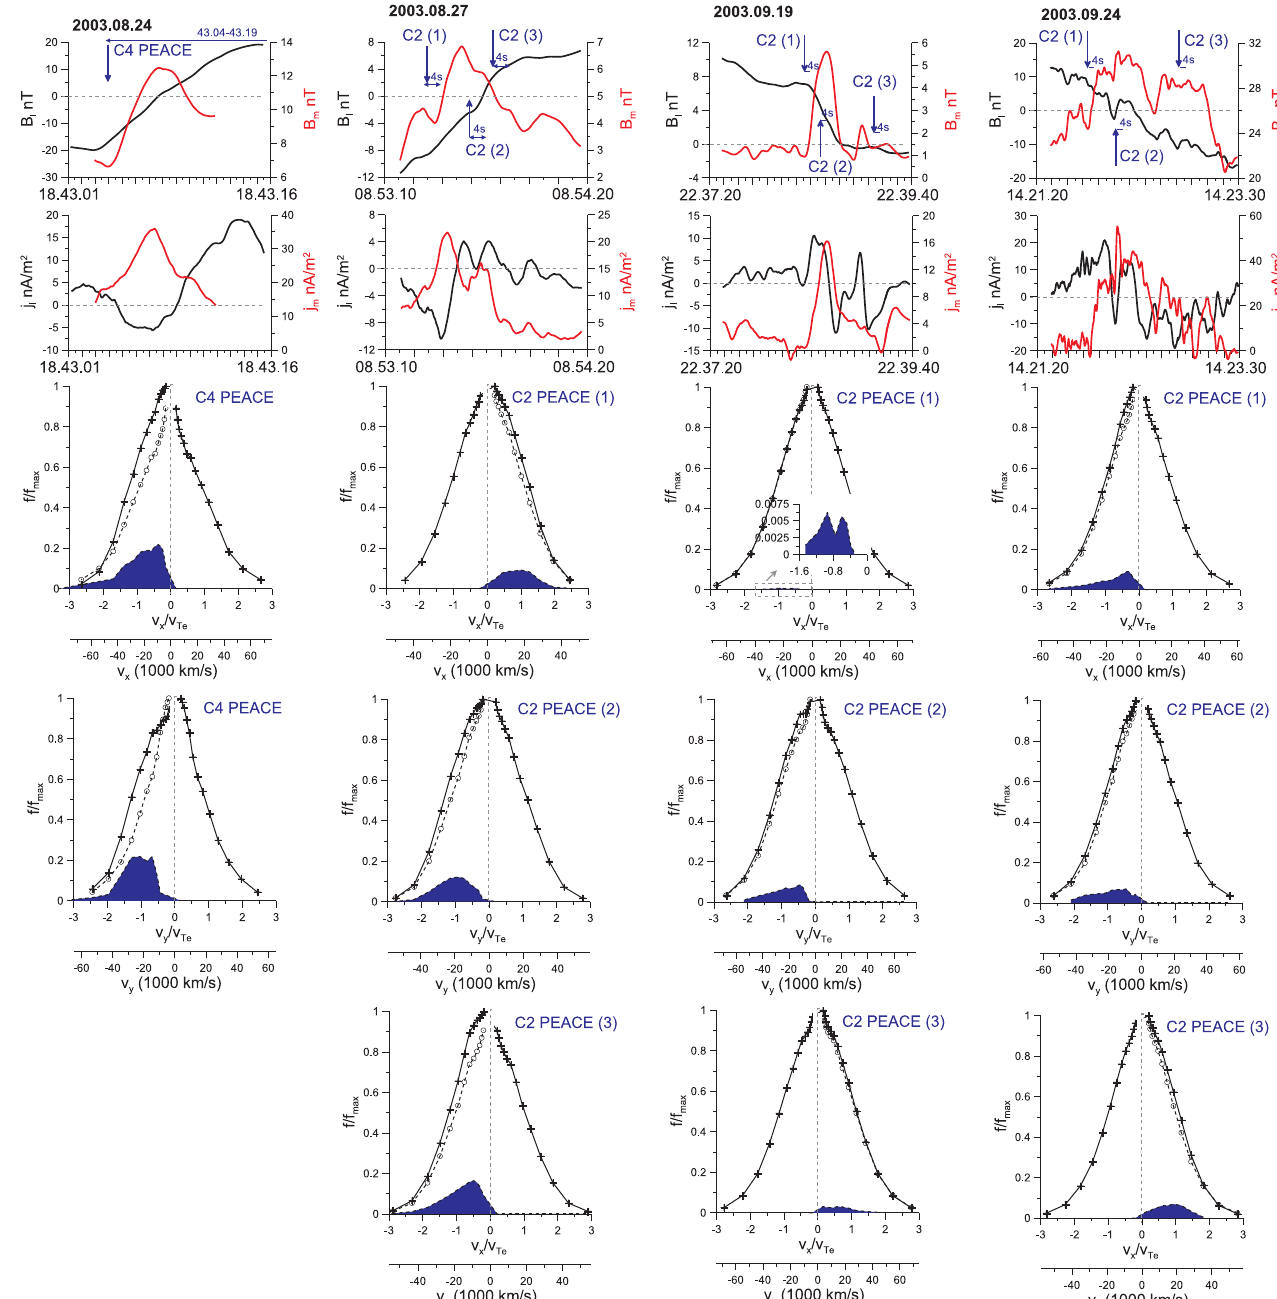
Figure 2. The analysis of electron distribution functions observed in CSs nos. 1–4. Four columns correspond to CSs nos. 1–4, respectively. The first and second rows show profiles of l and m -components of the magnetic field and the curlometer current density. The lower rows present electron distribution functions R f e ( v ) d v x d v z or R f e ( v ) d v y d v z at points indicated with arrows in the first row. In each panel the true distribution function normalized over its maximum value is shown by crosses. Circles present the reflection of one of the wings of the distribution function with respect to v y = 0 or v x = 0. The difference of the true distribution function and the reflected part is indicated by the blue filled region.